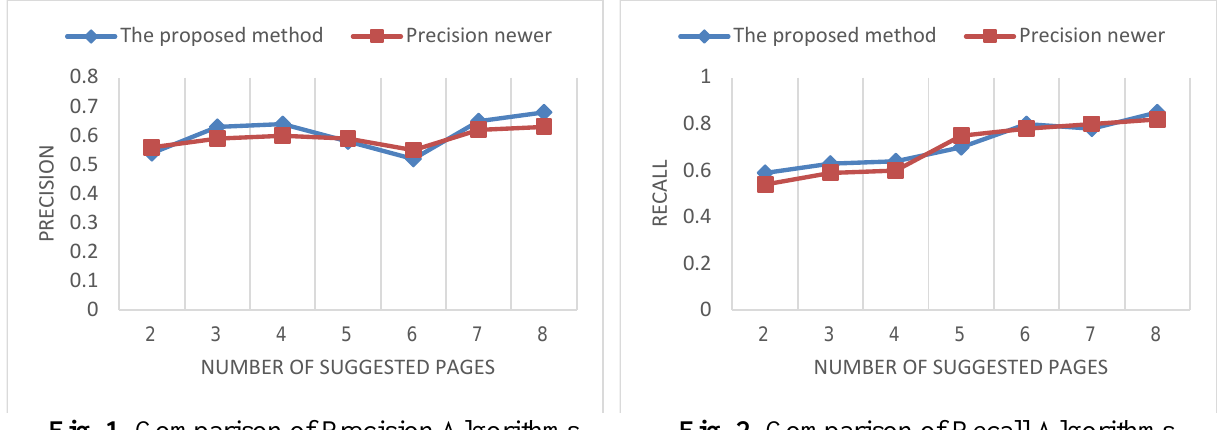
Fig. 1. Comparison of Precision Algorithms Fig. 2. Comparison of Recall